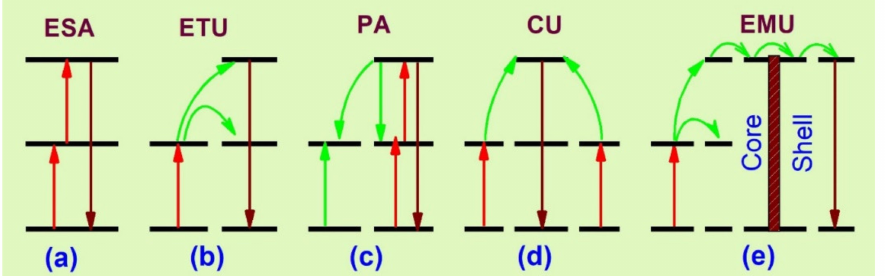
Figure 1. Schematic representation of basic upconversion processes [23]. ( a ) excited stte absorption; ( b ) energy transfer upconversion; ( c ) photon avalanche; ( d ) co-operative upconversion; ( e ) energy migration